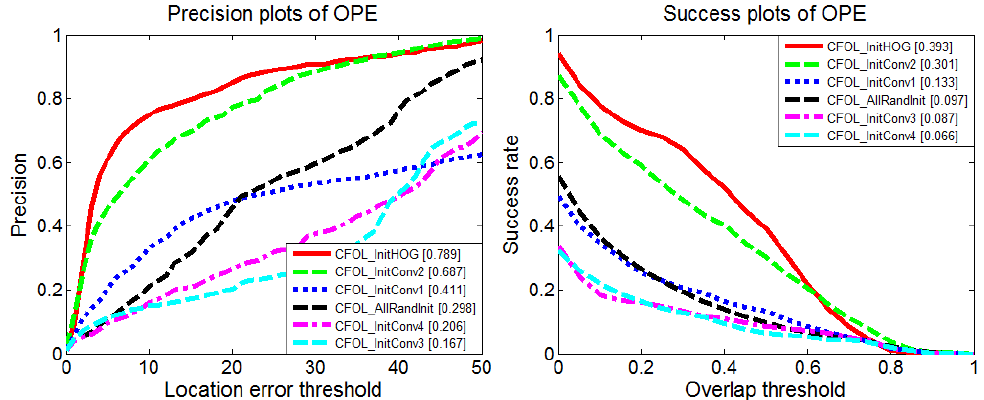
Figure 8. Performance comparison with different initialization